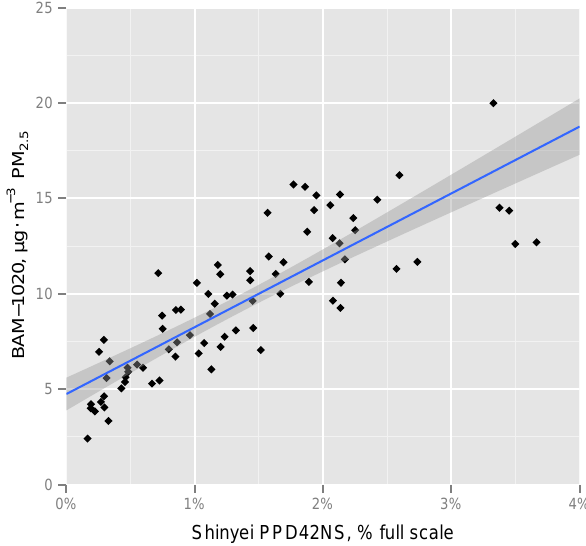
Fig. 4. 24h arithmetic means of 1h data collected between 1 Au- gust 2013 and 15 November 2013 at the West Oakland site. The superimposed line and shading represents a linear regression, fit by ordinary least squares ( R 2 =0.72), along with its 95% pointwise confidence